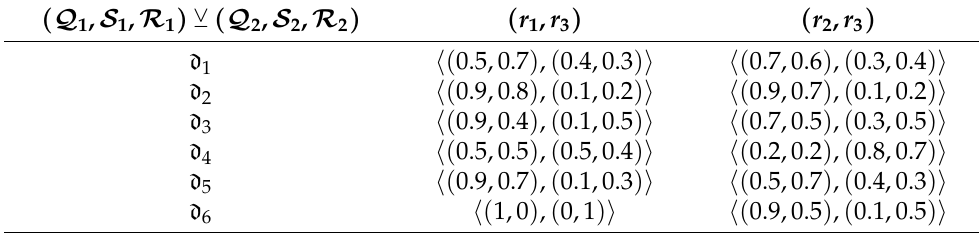
Table 9. Table for the 7-ROFBSS ξ 1 (cid:89) ξ 2